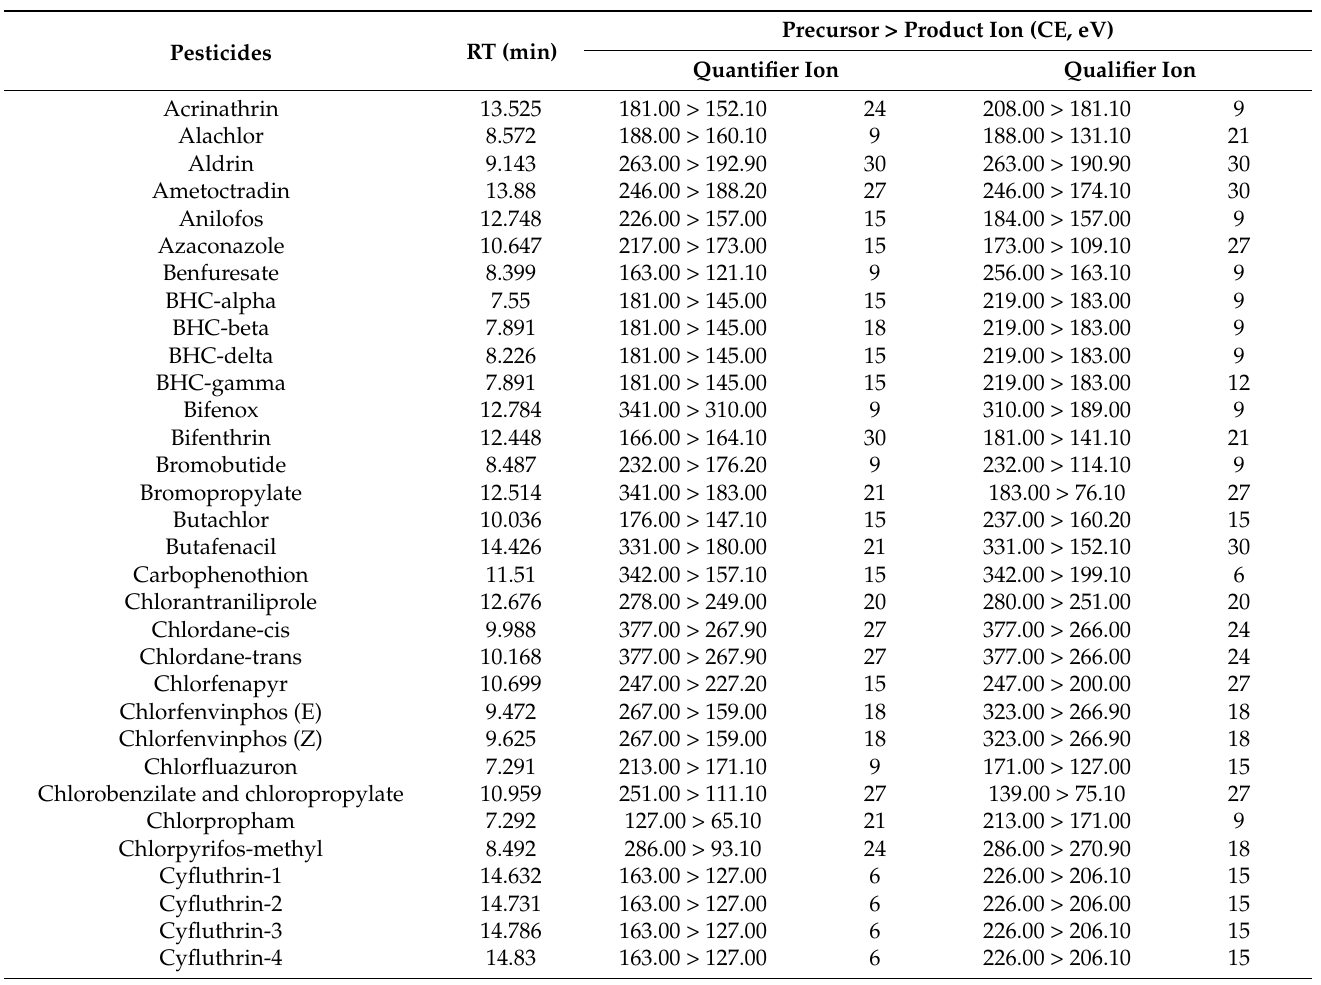
Table 1. MRM conditions for the first 40 pesticides in the GC–MS/MS analysis. MRM conditions for the other 83 pesticides are listed in Table